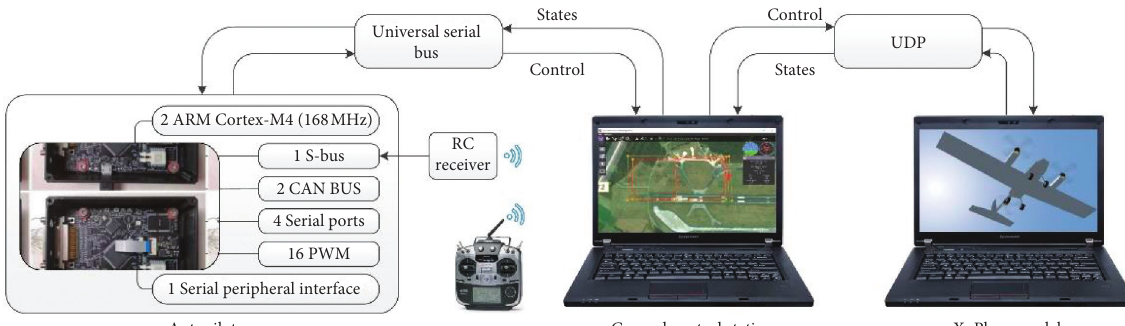
Figure 12: HIL simulation system.